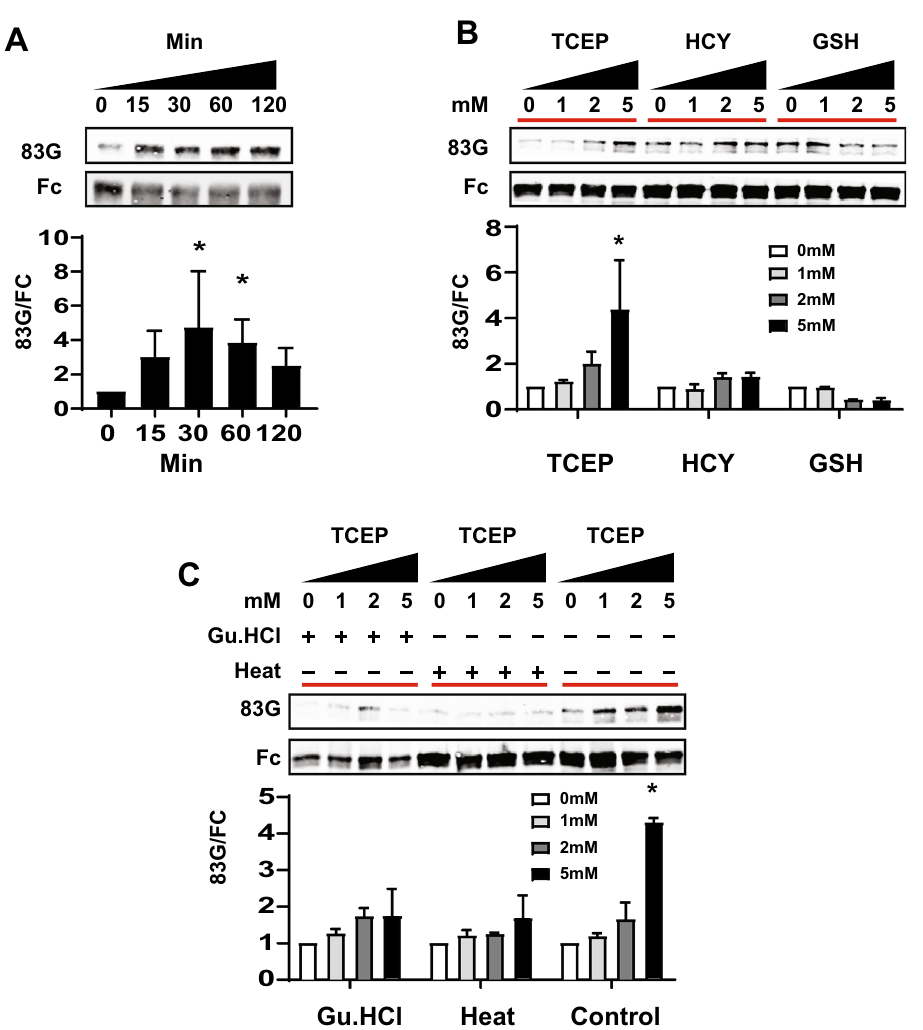
Figure 6. Effect of redox and denaturation on purified NOTCH3 ectodomain cleavage. ( A ) Time course of generation of neo-epitope from purified Fc-E3 protein. Protein was incubated at 37 °C for specific periods of time in TCEP (2 mM) and the analyzed by immunoblotting using probes denoted. 83G was used to quantify neo-epitope released from Asp121 cleavage; Fc was determined on the same blot to normalize protein in each lane. Quantification from five experiments is shown below. ( B ) Fc-E3 protein containing Fc linked to the first three EGF-like domains of NOTCH3 were exposed to increasing concentrations of reductants shown (homocysteine [HCY] and reduced glutathione [GSH]). Western analysis was performed on proteins with 83G to reveal the amount of cut protein and with Fc to normalize for total loaded protein. The ratio of cut to total input protein is displayed below, calculated from three experiments. ( C ) Protein denaturation by chaotropic agents (guanidine HCl [GnHCl] at 1 M) or heat (65 °C for 60 min) was performed prior to the addition of TCEP at specified concentrations to determine whether native structures are necessary for proteolysis at Asp121 (detected by 83G). Total protein was normalized by probing for Fc and the ratio of 83G/Fc determined in three